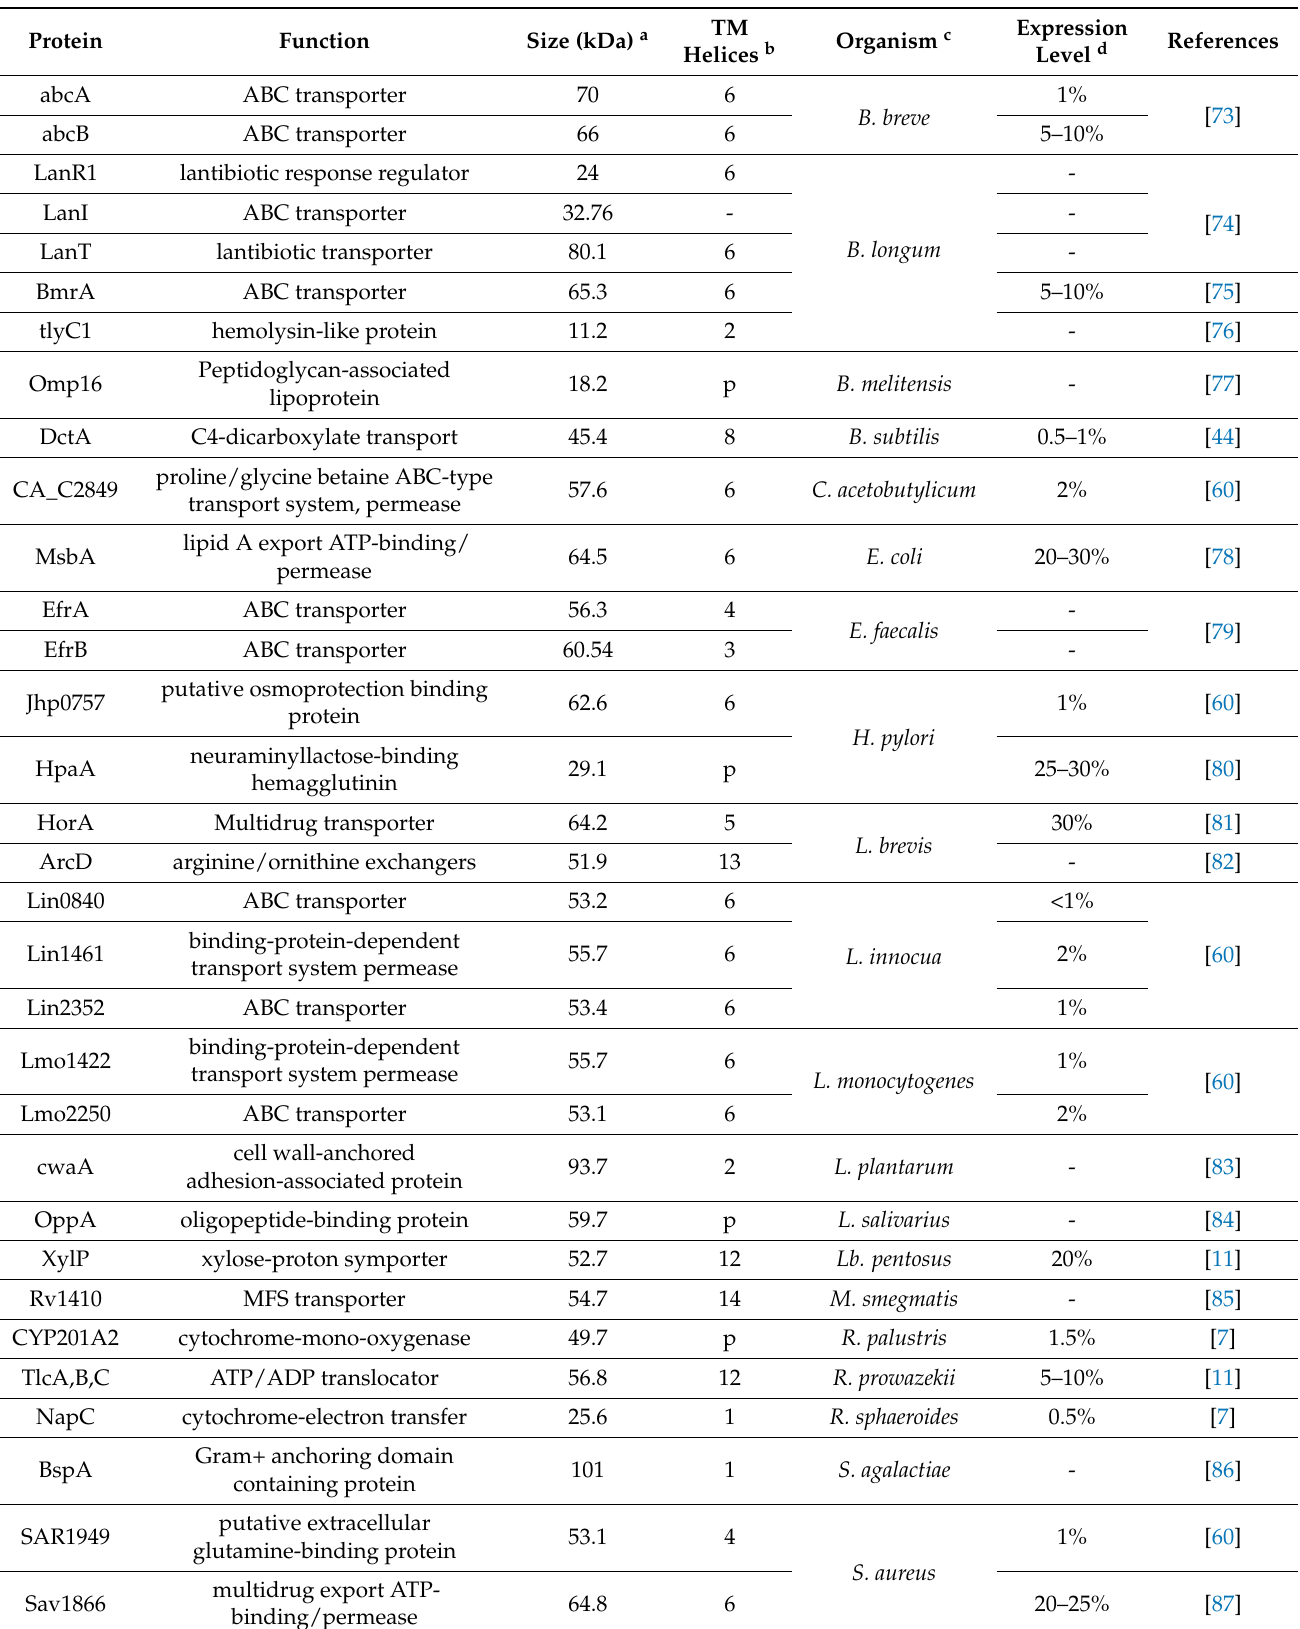
Table 3. List of heterologous prokaryotic